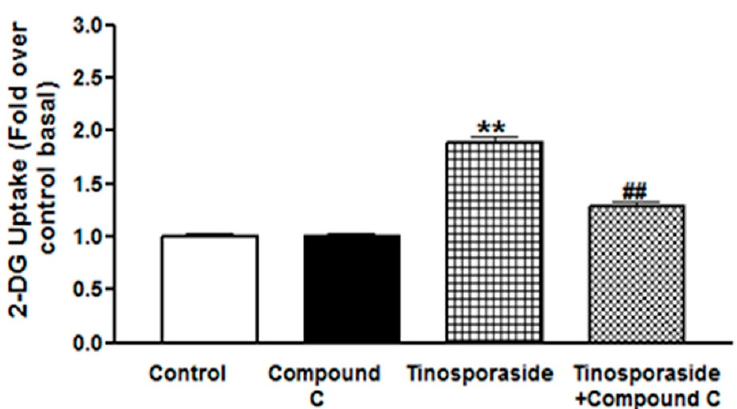
Figure 5. Effect of Compound C on tinosporaside-induced glucose uptake in L6 myotubes. L6 myotubes were treated with tinosporaside in the absence or presence of compound C for 30 min, which was followed by the determination of 2-DG uptake. Results shown are mean ± SE of three independent experiments. ** p < 0.01, relative to control; ## p < 0.01, relative to the tinosporaside treated group.